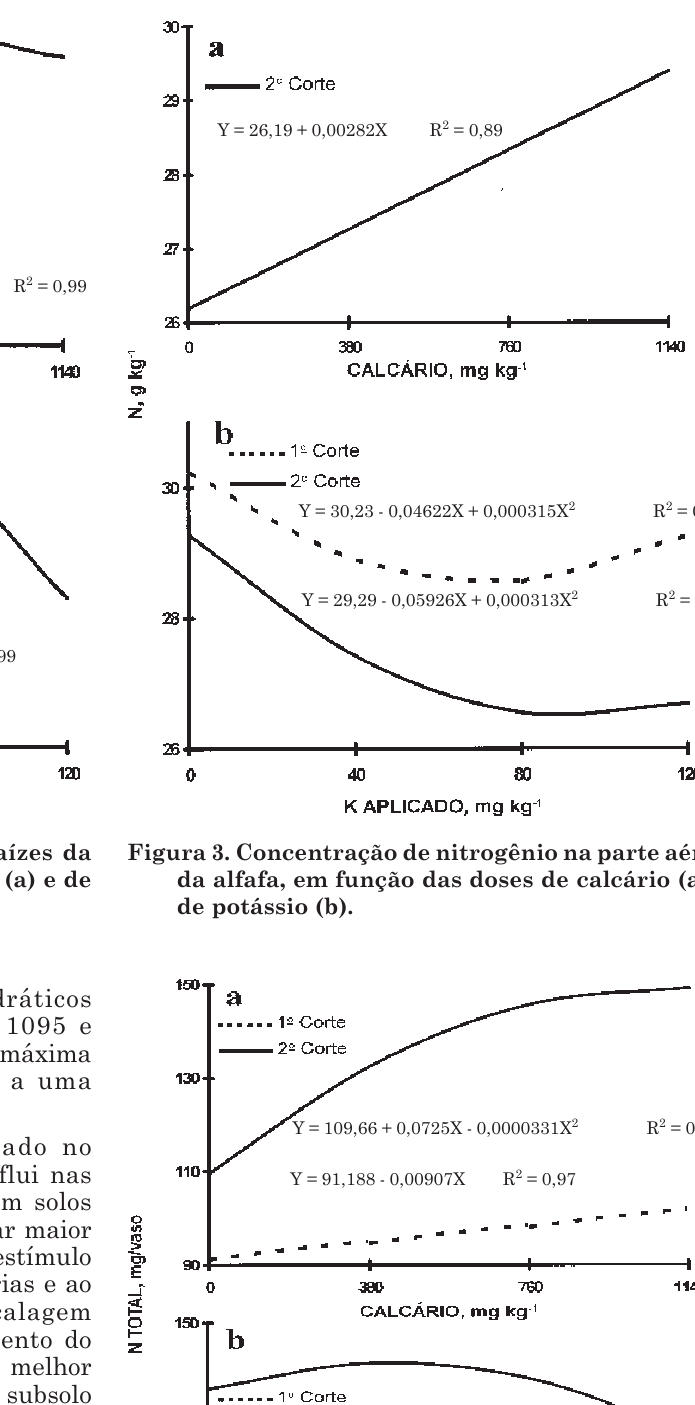
Figura 4. Quantidade total de nitrogênio na parte aérea da alfafa, em função das doses de calcário (a) e de potássio